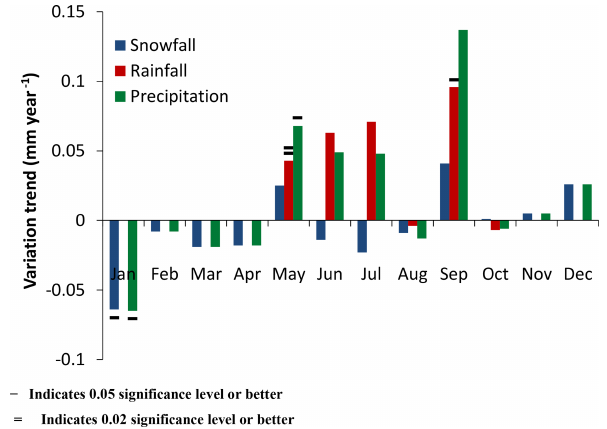
Figure 9. The variation trends of rainfall, snowfall and precipitation for each month at Utqia˙gvik from January 1952 to December 2015. The trend is characterized by the slope of the linear regression equa- tion of the time series ( − indicates 0.05 significance level or better; = indicates 0.02 significance level or